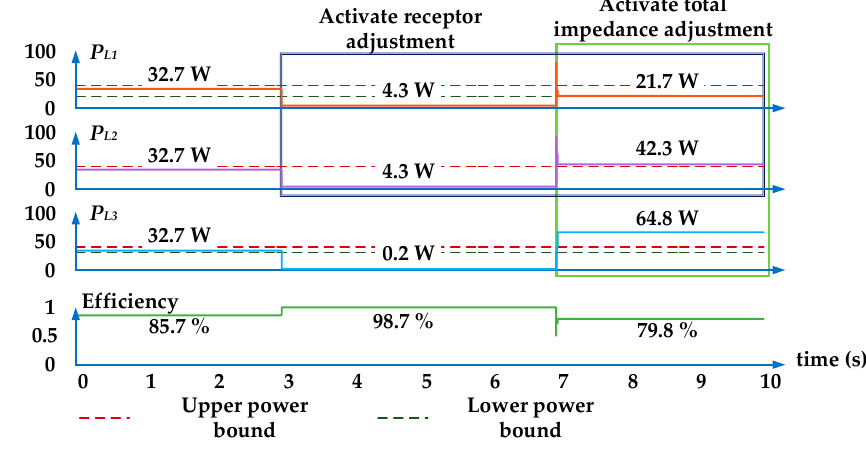
Figure 6. Comparative results.